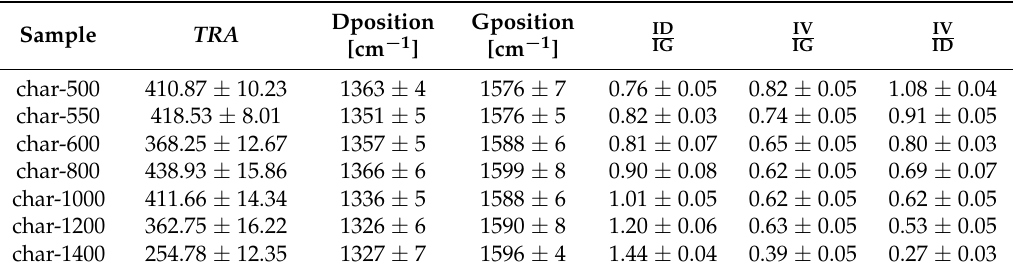
Table 4. Evolution of the Total Raman Area (TRA), D and G band position as well as intensity ratios as a function of the pyrolysis reactor temperature.